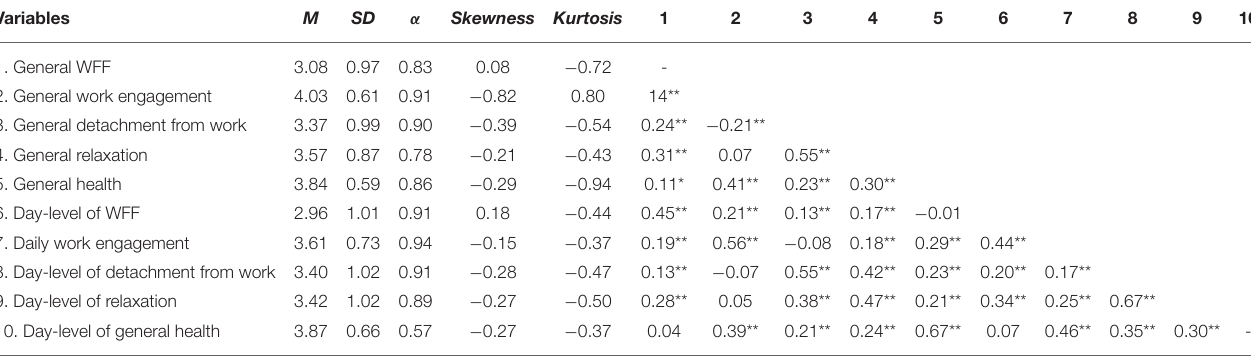
TABLE 1 | Means, standard deviation, Cronbach’s alpha, and correlations between the person and day-level variables ( N = 520 observations, N = 104 participants). Variables M SD